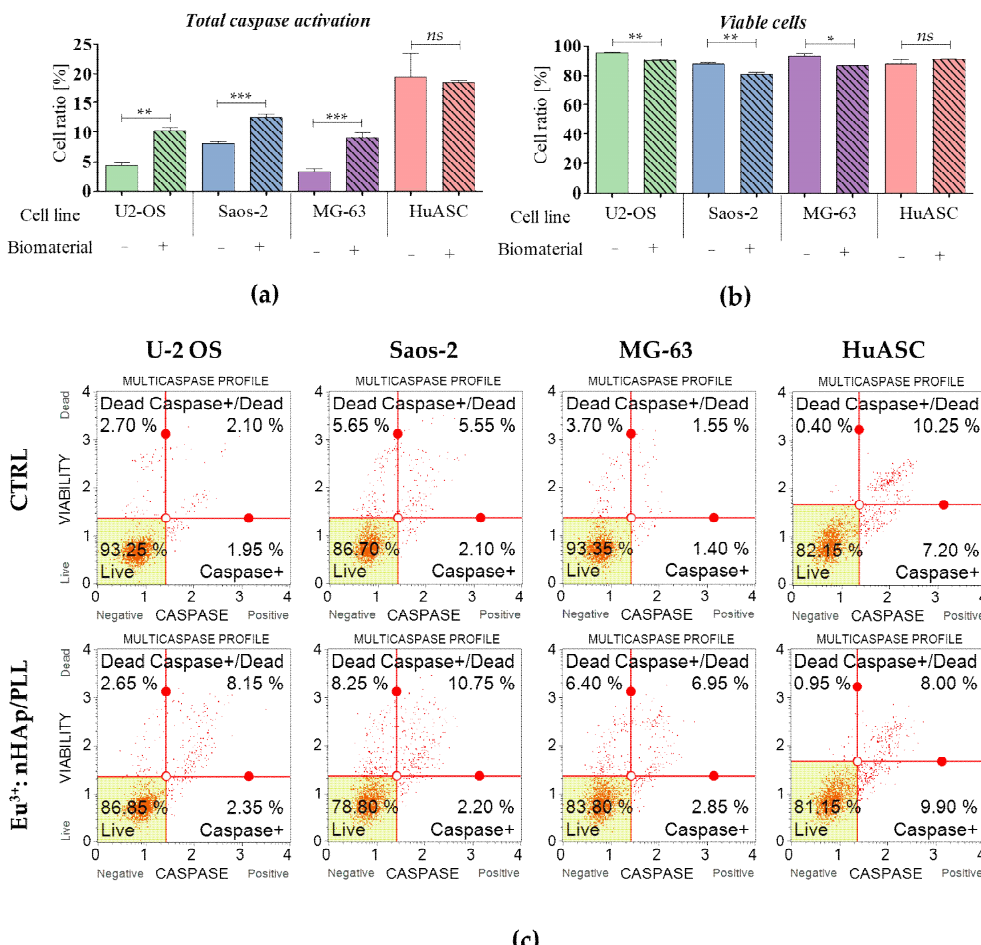
Figure 3. Caspase activity measured in cultures propagated on a polystyrene (CTRL) and on the scaffold (10 wt % 3 mol % Eu 3+ : nHAp/PLLA. ( a ) The comparison analysis of caspase positive cells. ( b ) Comparison analysis of cells’ viability. ( c ) The representative graphs obtained during cytometric-based analysis indicate on cells’ distribution based on caspase activation. Cells were separated into four populations: live ( Live —bottom left corner), initial activity of caspases ( Caspase + - down right corner), advanced activity of caspases ( Caspase + / Dead —upper left corner) and dead ( Dead – upper right corner). The statistically significant differences were marked with an asterisk (***p < 0.001; **p < 0.01, *p < 0.05). Non-significant results of comparison are marked as ns .